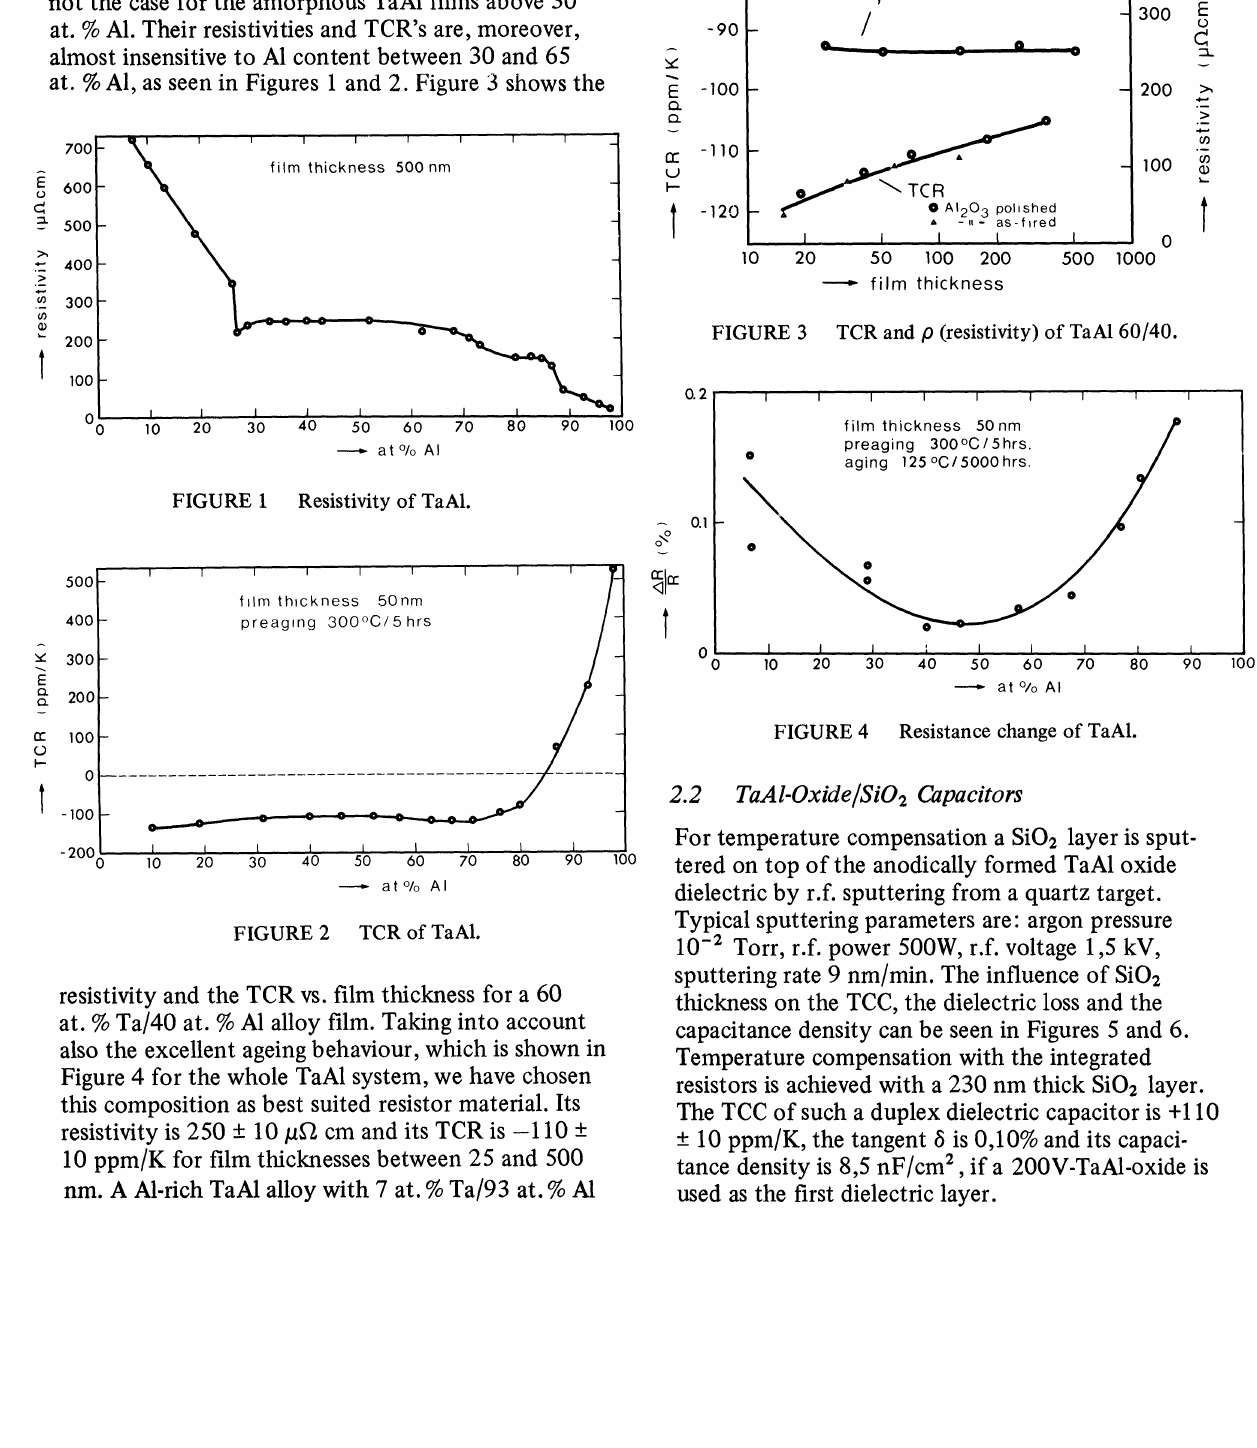
FIGURE 3 TCR and p (resistivity) of TaA1 60/40. 0.2